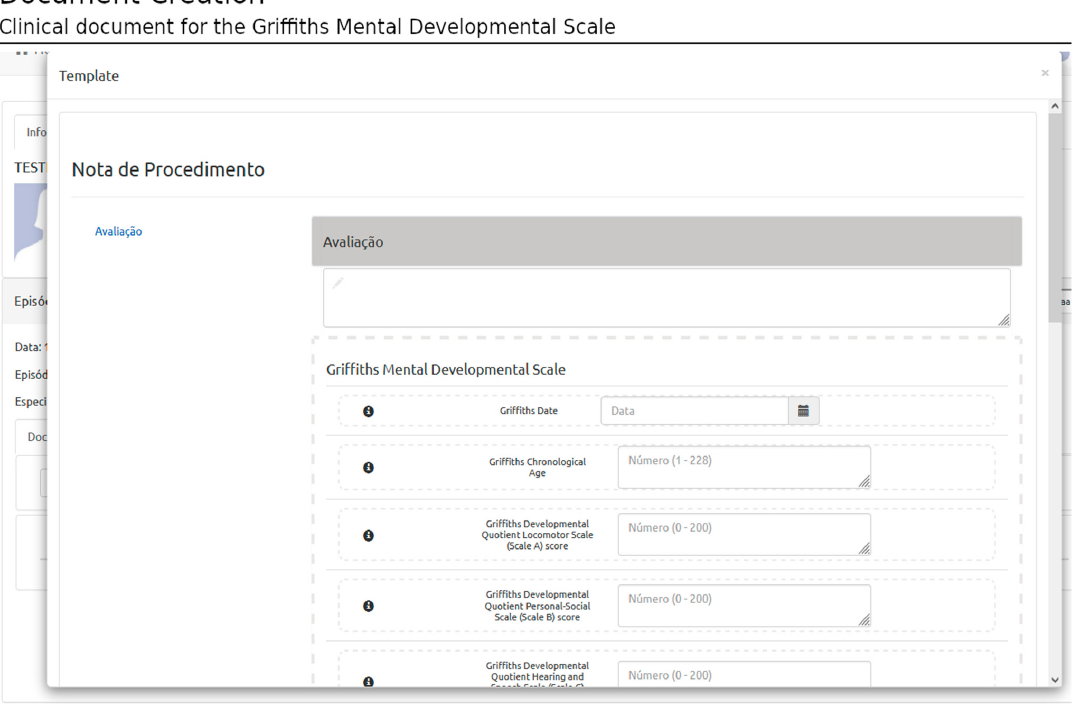
Figure 8. Document creation: Clinical document. This figure shows a clinical record for the Griffiths Mental Developmental Scale generated with the rules defined in the template of Figure 2. (The Portuguese terms have the following translations in English: Nota de Procedimento: Procedure Note and Avaliação: Assessment). mented rules. The interface implements the printing of the stored XML files as a portable document format (PDF) file for reporting purposes (these files may function as attach- ments to other EHR systems) (Figure 9).